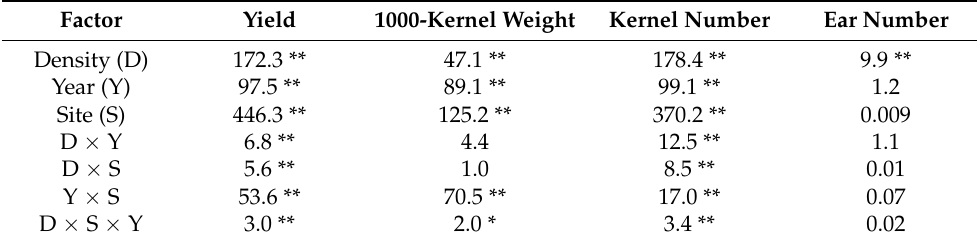
Table 4. Analysis of variance for grain yield and its